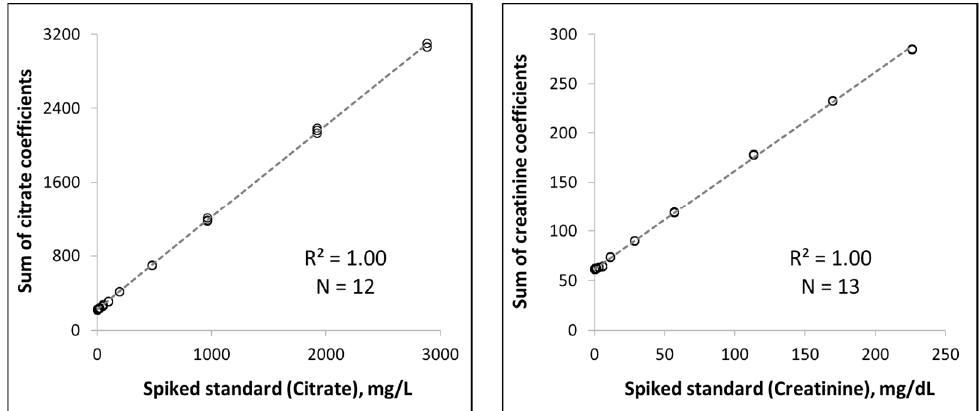
Figure 3. Standard curves for the determination of citrate and creatinine concentrations.